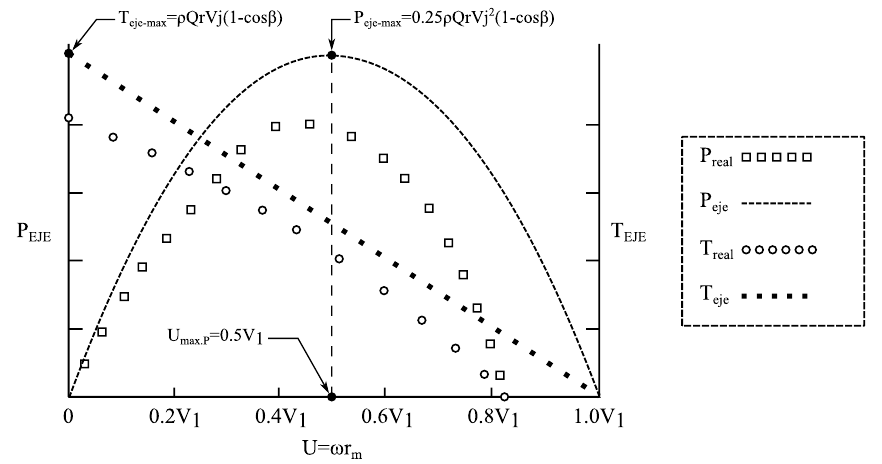
Figure 3. Power and Torque vs. Rotational Speed.